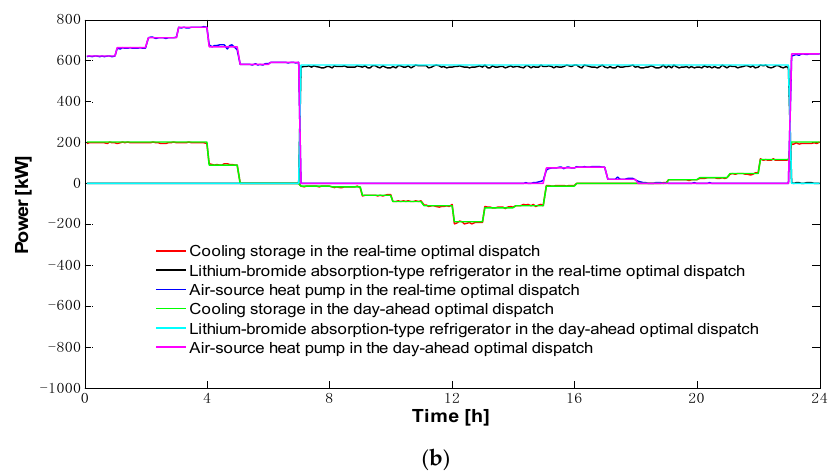
Figure 13. Comparison of electricity-supply units ( a ) and cooling-supply units ( b ) in summer between the day-ahead optimal dispatch and real-time optimal dispatch.